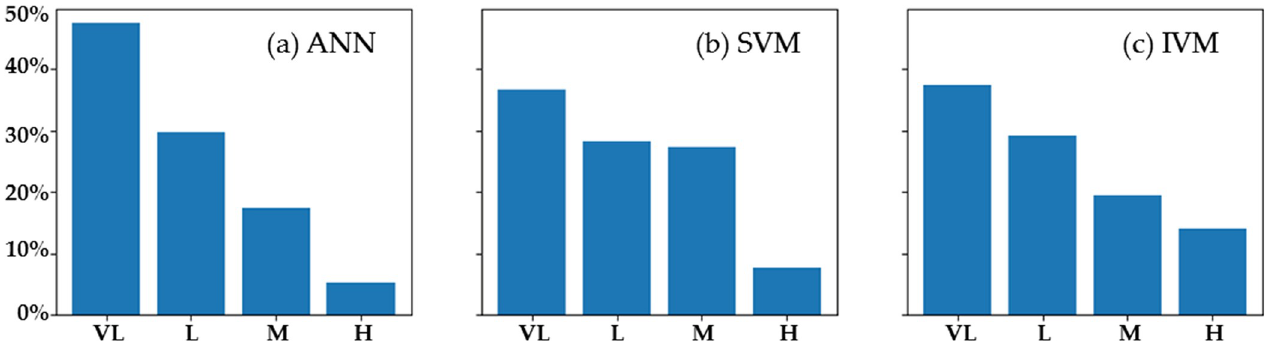
Fig 9. Percentage of each level mapping under different models, VL: Very low, L: Low, M: moderate, H: High.